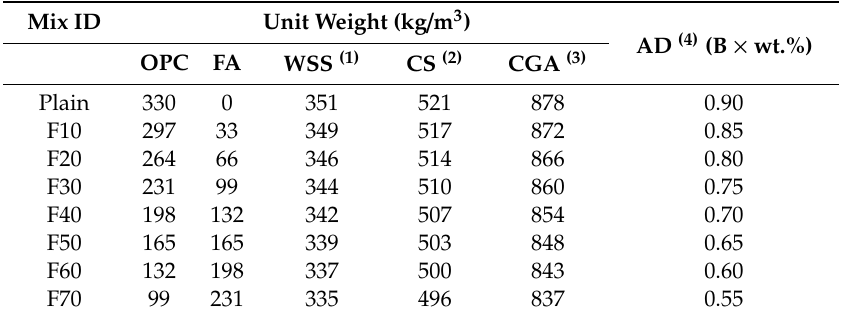
Table 4. Mixing rates of